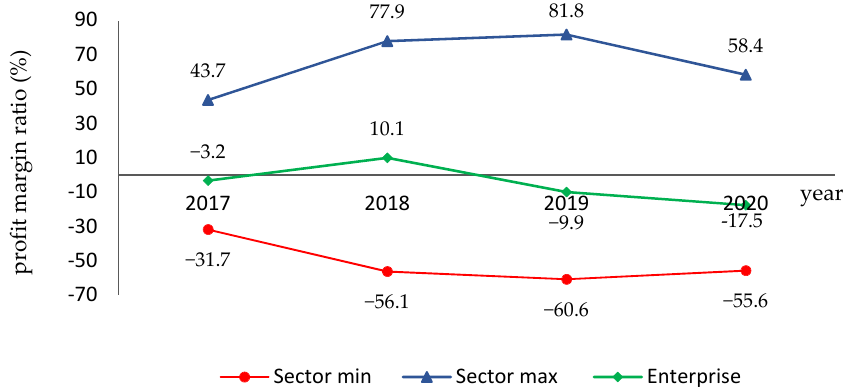
Figure 4. Total revenues and total costs in the enterprise in 2017–2020 (thousand PLN).